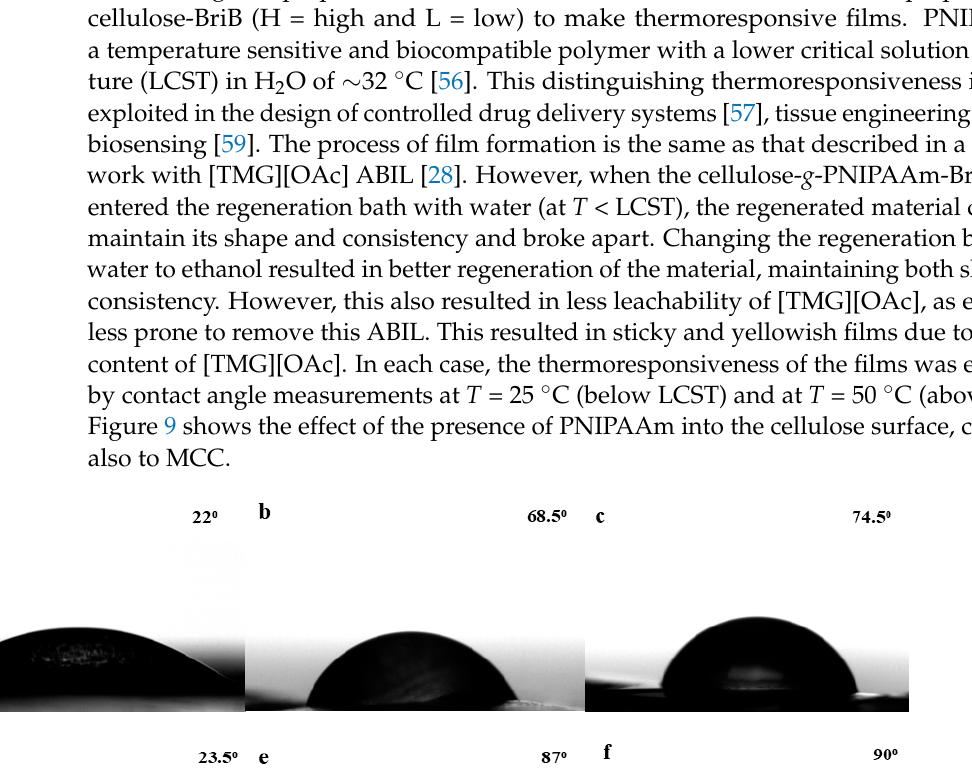
Figure 10. Contact angle measurement of ( a ) cellulose (MCC) control film, ( b ) Cellulose pulp + Cel- lulose(H)- g -PNIPAAm-Br film at T = 25 °C, ( c ) Cellulose pulp + Cellulose(H)- g -PNIPAAm-Br film at T = 50 °C. When cellulose(H)- g -PNIPAAm-Br was mixed with 50 wt% cellulose pulp (Figure 10b), the contact angle increased from 22° to 39° compared to the control sample (Figure 10a). When the film was heated to T = 50 °C, the contact angle also increased to 61°, prov- ing the thermoresponsiveness of the resulting film. The value obtained is lower than for the pure cellulose PNIPAAm samples (Figure 9), which was expected due to the higher cellulose content in the final films. This confirms the thermoresponsive behavior of